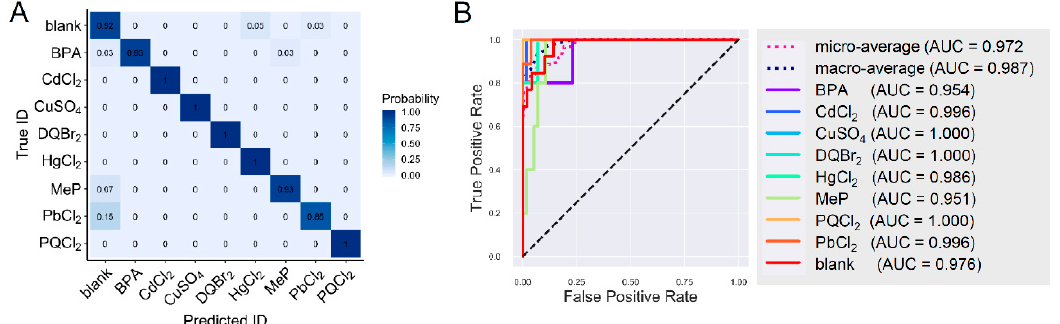
Figure 5. The confusion matrix ( A ) and Receiver Operating Characteristic (ROC) curves ( B ) for the library of cyclic square wave voltammetry of seawater spiked with environmental contaminants using a multilayer graphene as the working electrode.